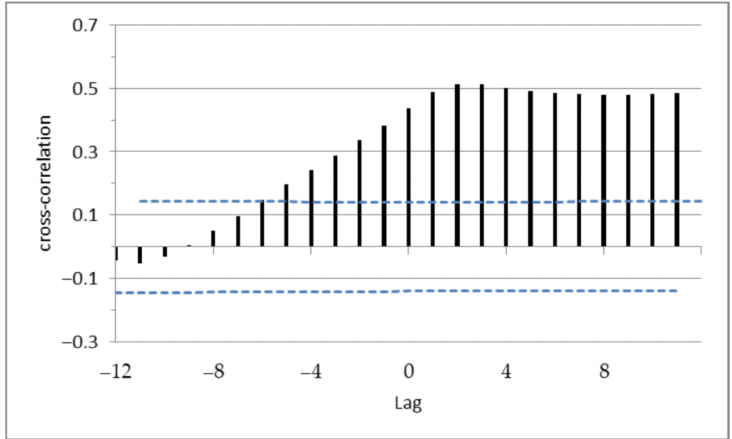
Figure 8. Results for cross correlation between SPEI values and reservoir storage water volumes in Kouris